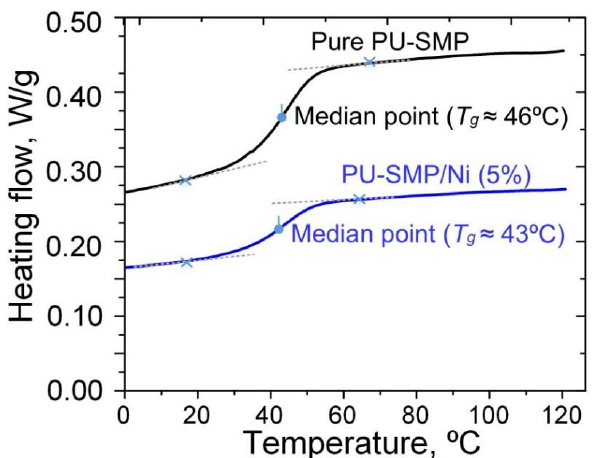
Figure 5. Differential Scanning Calorimetry (DSC) results of pure polyurethane-based Shape Memory Polymer (SMP) and SMP/Ni (Nickel) composite.